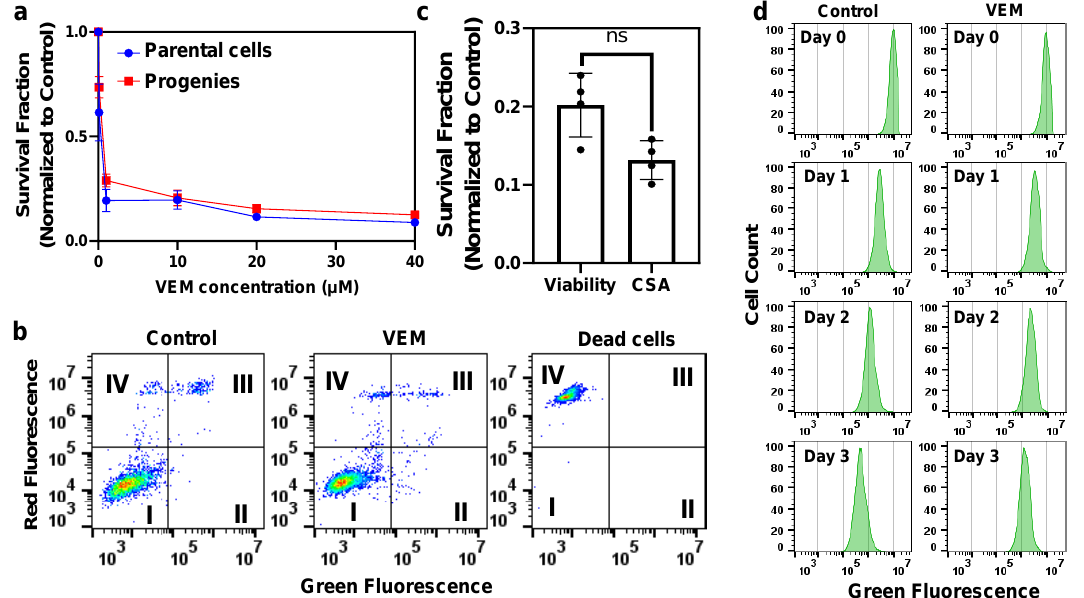
Figure 1. Persisters are slow-cycling, drug-tolerant cells. ( a ) A375 cells were treated with VEM at indicated concentrations for 3 days. After treatment, surviving cells were collected for the assessment of their viability with trypan blue staining. The survival fraction was calculated by normalizing the number of live cells in the treatment culture with the total number of cells in the untreated control group. Number of biological replicates n = 4. ( b ) A375 cells after VEM treatment were collected and cultured in a fresh, drug-free growth medium for 24 h. Then, the cells were stained with an annexin-V/fluorescein isothiocyanate (FITC) conjugate and propidium iodide (PI) to detect apoptotic cells. Of note, PI is a membrane-impermeant dye that can only penetrate the damaged, permeable membranes of dead cells. The cell populations were gated to represent (I) live (FITC − /PI − ), (II) early apoptotic (FITC + /PI − ), (III) late apoptotic (FITC + /PI + ), and (IV) dead (FITC − /PI + ) cells. ( c ) After treatment, A375 cells were collected to test their viability with STYO60/SYTOX green staining and clonogenic survival assays (CSA) (see Section 4). ns: not significant ( t -test, p < 0.05). n = 4. ( d ) A375 cells pre-stained with CFSE were either treated with VEM or left untreated. At indicated time points, the fluorescence of the cells was measured with flow cytometry. n =